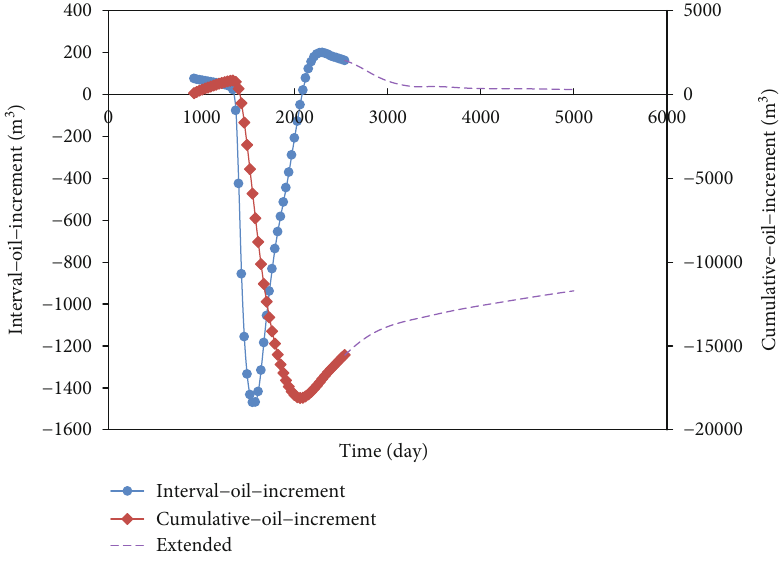
Figure 12: Comparison of oil